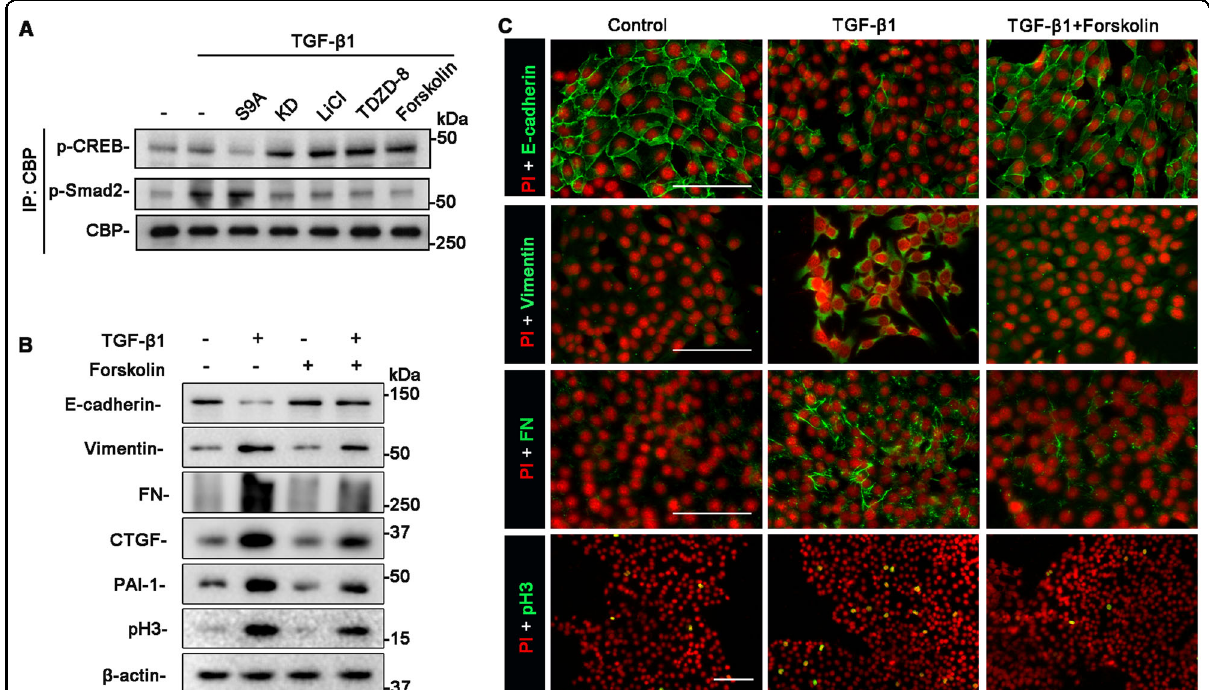
Fig. 5 GSK3 β suppresses the activity of CREB, which competes with Smad proteins for binding to CBP and abolishes the TGF- β 1 induced TEC pro fi brogenic plasticity. TKPT cells were pretreated with lithium, TDZD-8, or forskolin, or were subjected to liposome-mediated transient transfection with vectors encoding KD, or S9A, followed by TGF- β 1 treatment for 6 h. A Cell lysates were subjected to immunoprecipitation with the anti-CBP antibody. Immunoprecipitates were processed for immunoblot analysis for p-CREB (ser 133), p-Smad2, and CBP. Representative immunoblots were shown. B Cell lysates prepared from TKPT cells with indicated treatments were processed for immunoblot analysis for E-cadherin, vimentin, FN, CTGF, PAI-1, pH3, and β -actin. Representative immunoblots were shown. C TKPT were fi xed after indicated treatments and prepared for immuno fl uorescent staining for E-cadherin, vimentin, FN, and pH3 with nuclear counterstaining with PI. Representative fl uorescent micrographs were shown. Scale Bar = 100 μ m. CREB, cAMP response element-binding protein; CBP, CREB-binding protein; PI, propidium